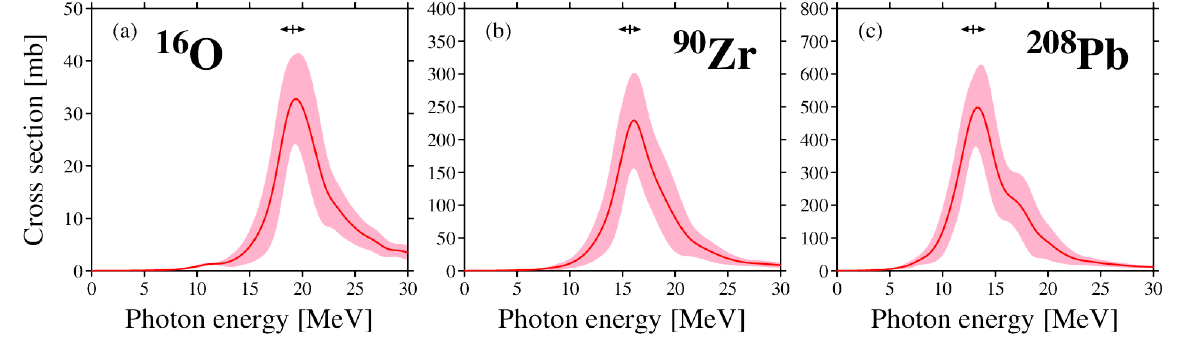
Fig. 3 Same as Fig. 1(c) but for (a) 16 O, (b) 90 Zr, and (c) 208 Pb.